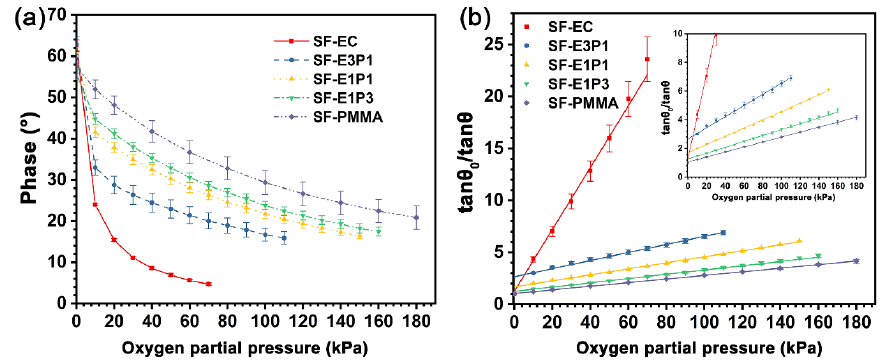
Figure 8. ( a ) Phase change of the sensing films with different matrices under different oxygen partial pressure at 20 ◦ C; ( b ) Stern-Volmer plots of the sensing films derived from ( a ). Inset: local